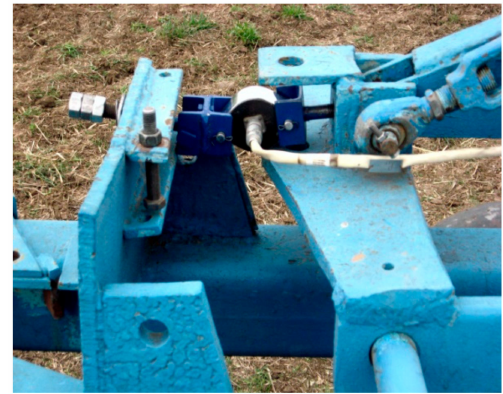
Figure 5. Strain-measuring plough.